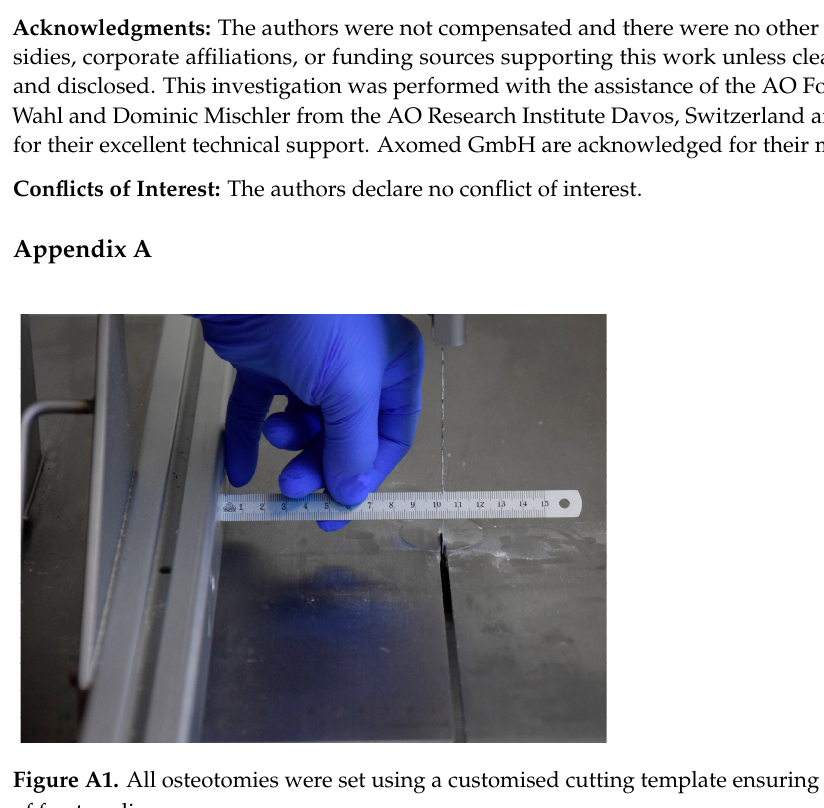
Figure A2. Predrilling for the SI screw insertion was performed with a 5.0 mm drill bit using cus- tomised PMMA guides for the S1 and S2 corridors. Figure A3. Standardised customised PMMA guide was used to predrill the entry points of the 5.0 mm Schanz screws with a 3.5 mm drill bit.